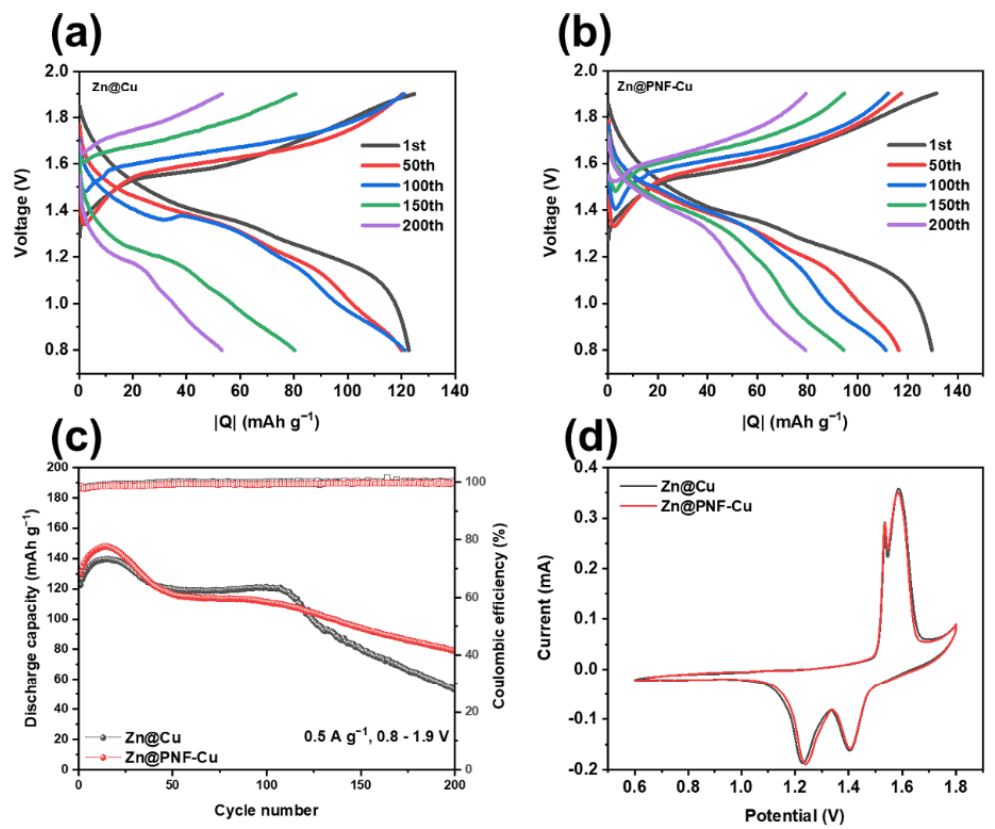
Figure 6. Zn-MnO 2 full-cell performance: charge and discharge curves of the cells using ( a ) Zn@Cu and ( b ) Zn@PNF-Cu, ( c ) cycling performance at 0.5 mA g −1 , and ( d ) CV curves at a scan rate of 0.1 and ( b ) Zn@PNF-Cu, ( c ) cycling performance at 0.5 mA g − 1 , and ( d ) CV curves at a scan rate of mV s −1 . 0.1 mV s − 1